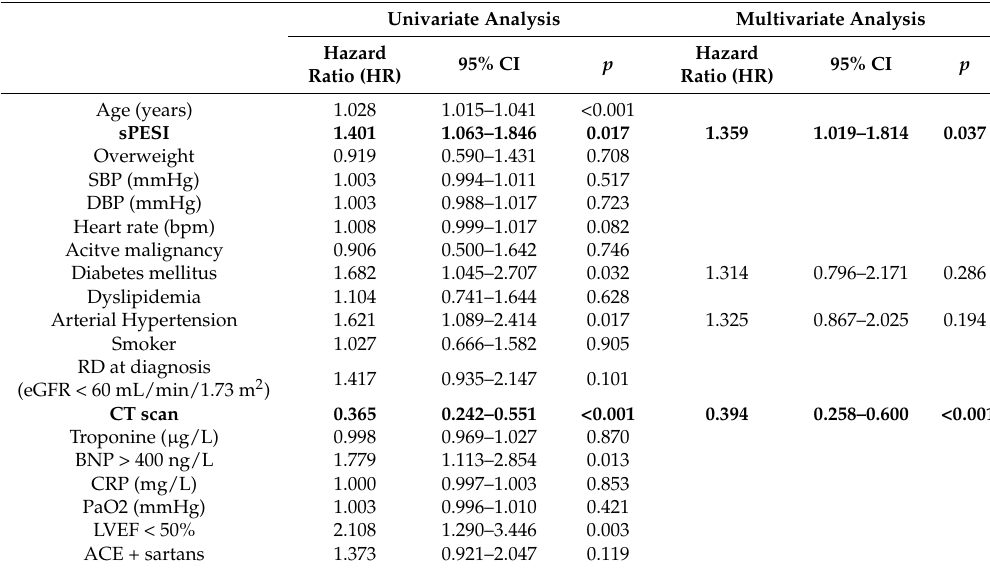
Table 2. Univariate and multivariate analyses for the prediction of acute kidney injury during hospital